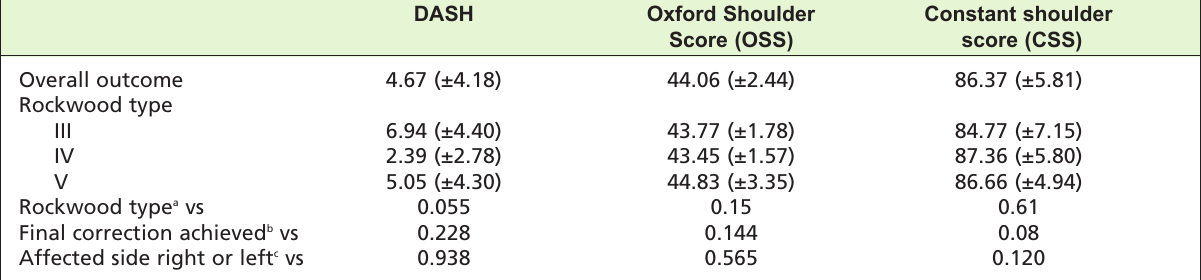
Table II: Functional outcome of 32 patients